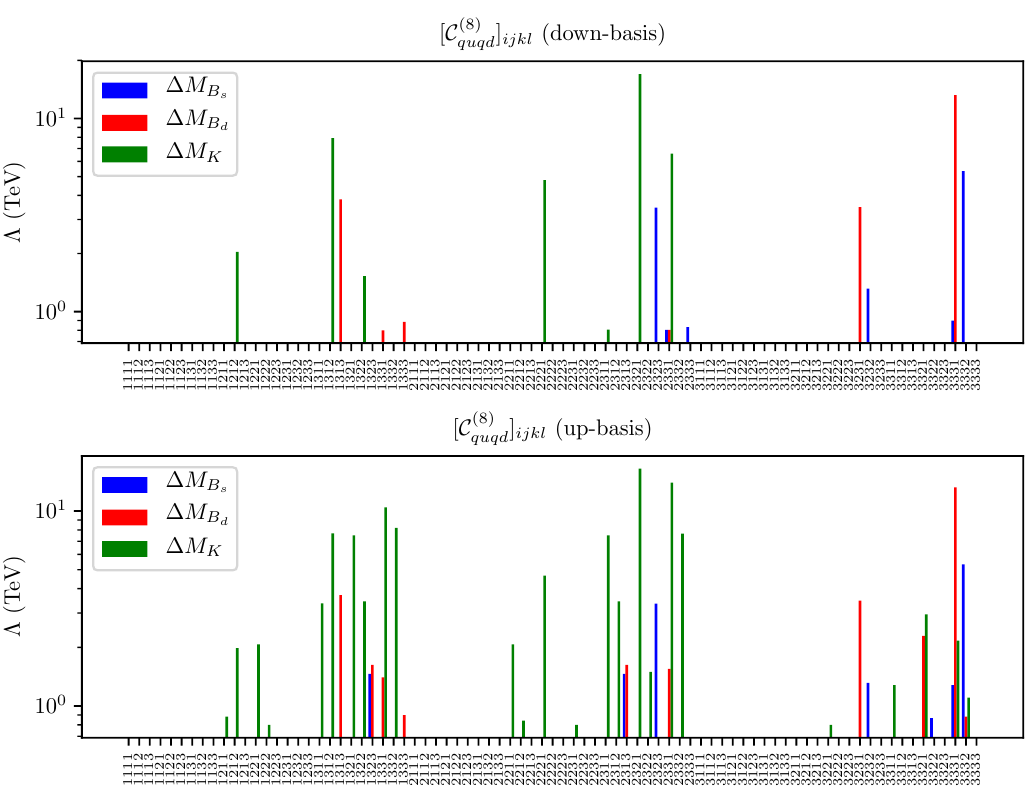
(cid:2) (cid:3) c (8) = 10 that corresponds to a 10% effect in quqd ijkl